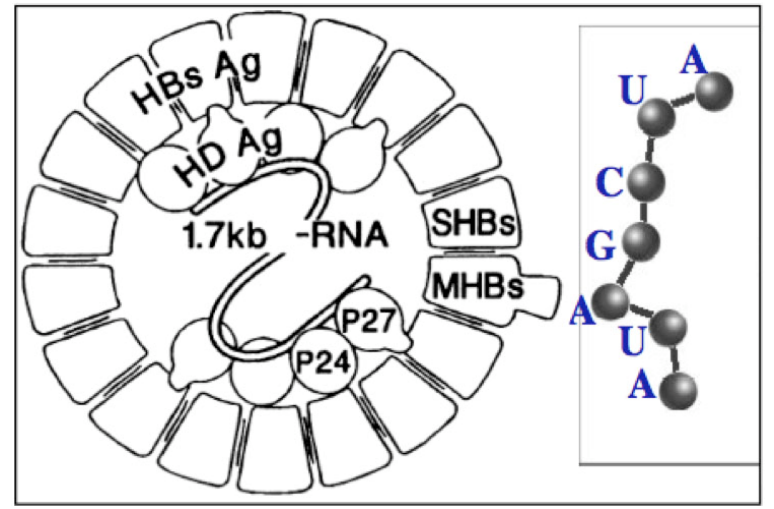
Figure 6. Circular Hepatitis D RNA (left) and miR substring of length 7.